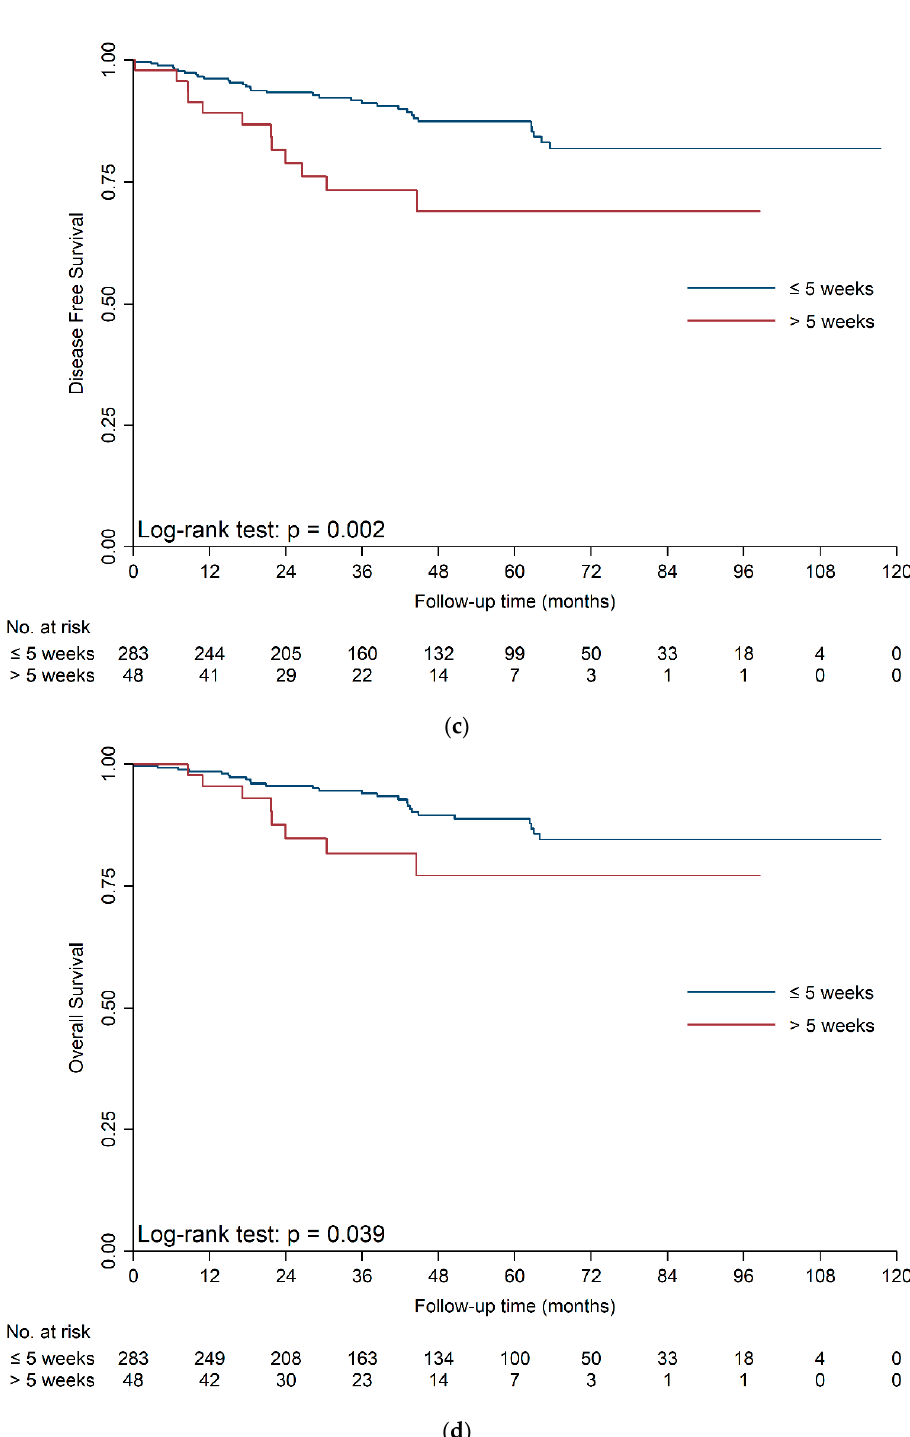
Figure 2. ( a ). The comparison of survival curves between two populations in T1a patients at the cut-off point of TTS = 5 weeks (DFS). Survival curves were generated by Kaplan-Meier method and compared by Log-rank test. ( b ). The comparison of survival curves between two populations in T1a patients at the cut-off point of TTS = 5 weeks (OS). Survival curves were generated by Kaplan-Meier method and compared by Log-rank test. ( c ). The comparison of survival curves between two populations in T1b patients at the cut-off point of TTS = 5 weeks (DFS). Survival curves were generated by Kaplan-Meier method and compared by Log-rank test. ( d ). The comparison of survival curves between two populations in T1b patients at the cut-off point of TTS = 5 weeks (OS). Survival curves were generated by Kaplan-Meier method and compared by Log-rank